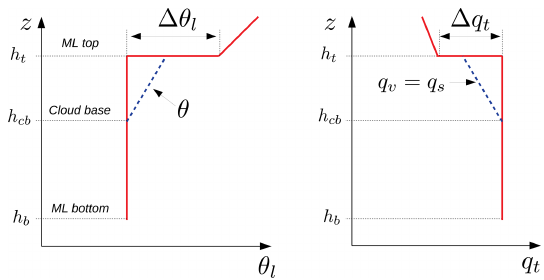
Figure C1. Schematic representation of the vertical profiles of the conserved variables θ l and q t in the mixed